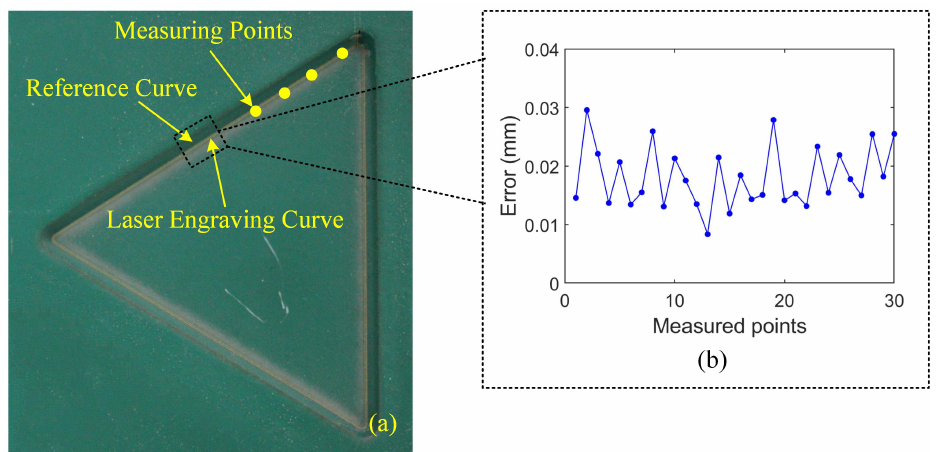
Figure 14. Processing results of the test part. ( a ) The example pattern of measurement. ( b ) The results of error